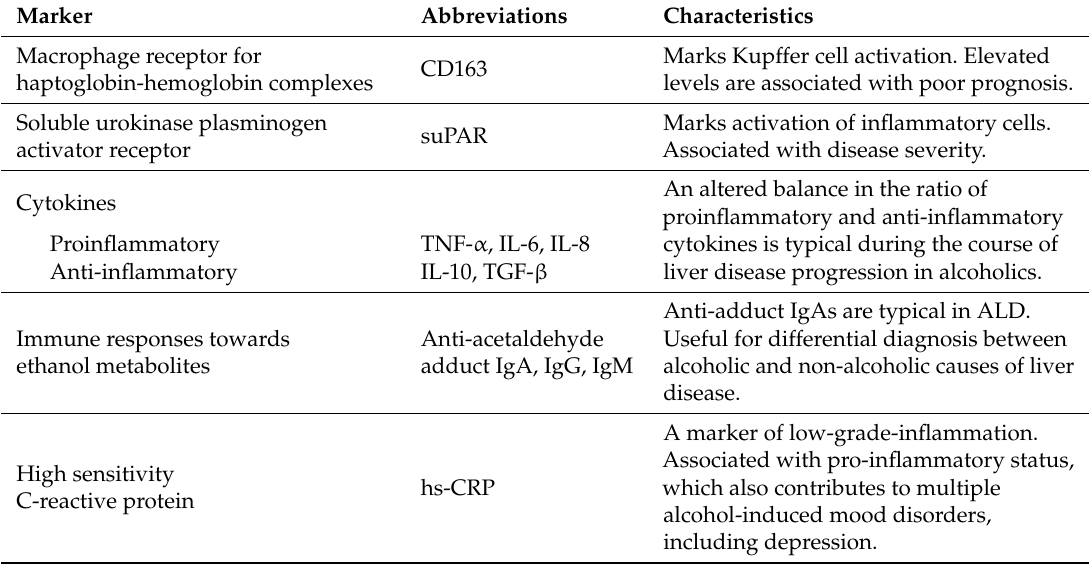
Table 5. Biomarkers of immune activation in